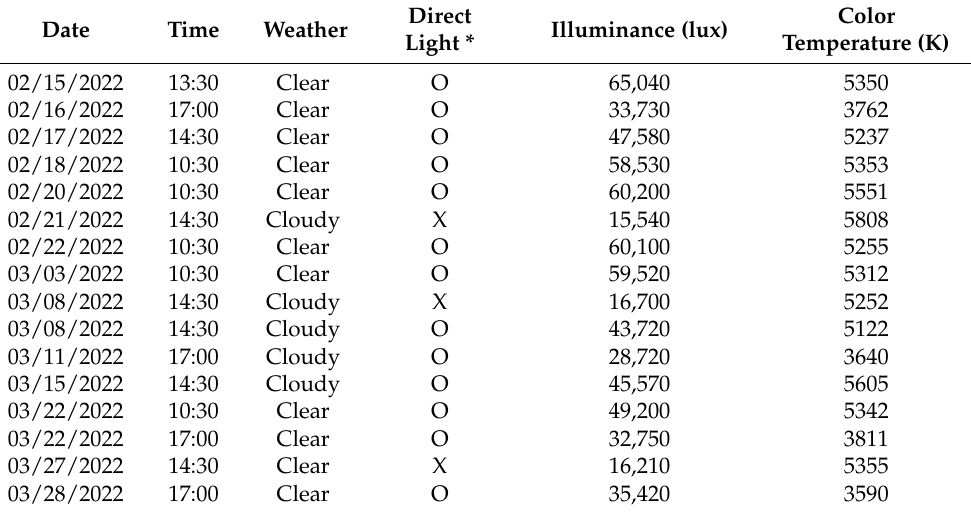
Table 1. Illuminance and color temperature of natural light in Goyang-si, Gyeonggi-do, Republic of